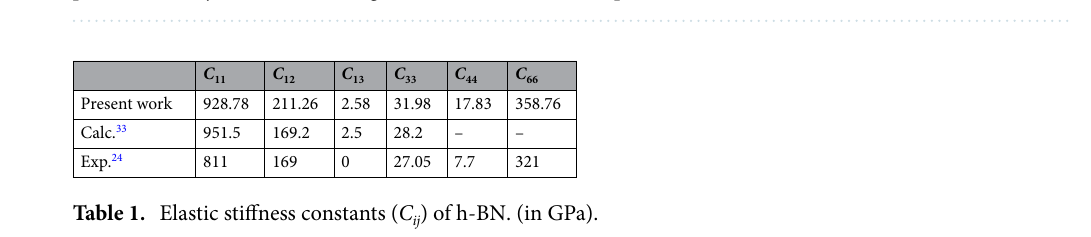
Figure 1. ( a ) Similarity of atomic structure of h-BN and graphite. h-BN has a polar bonding between two different elements, whereas those of graphite are non-polar. Schematics of SAW devices ( b ) utilizing h-BN as piezoelectric layer and ( c ) utilizing interfacial mode between piezoelectric material and h-BN.